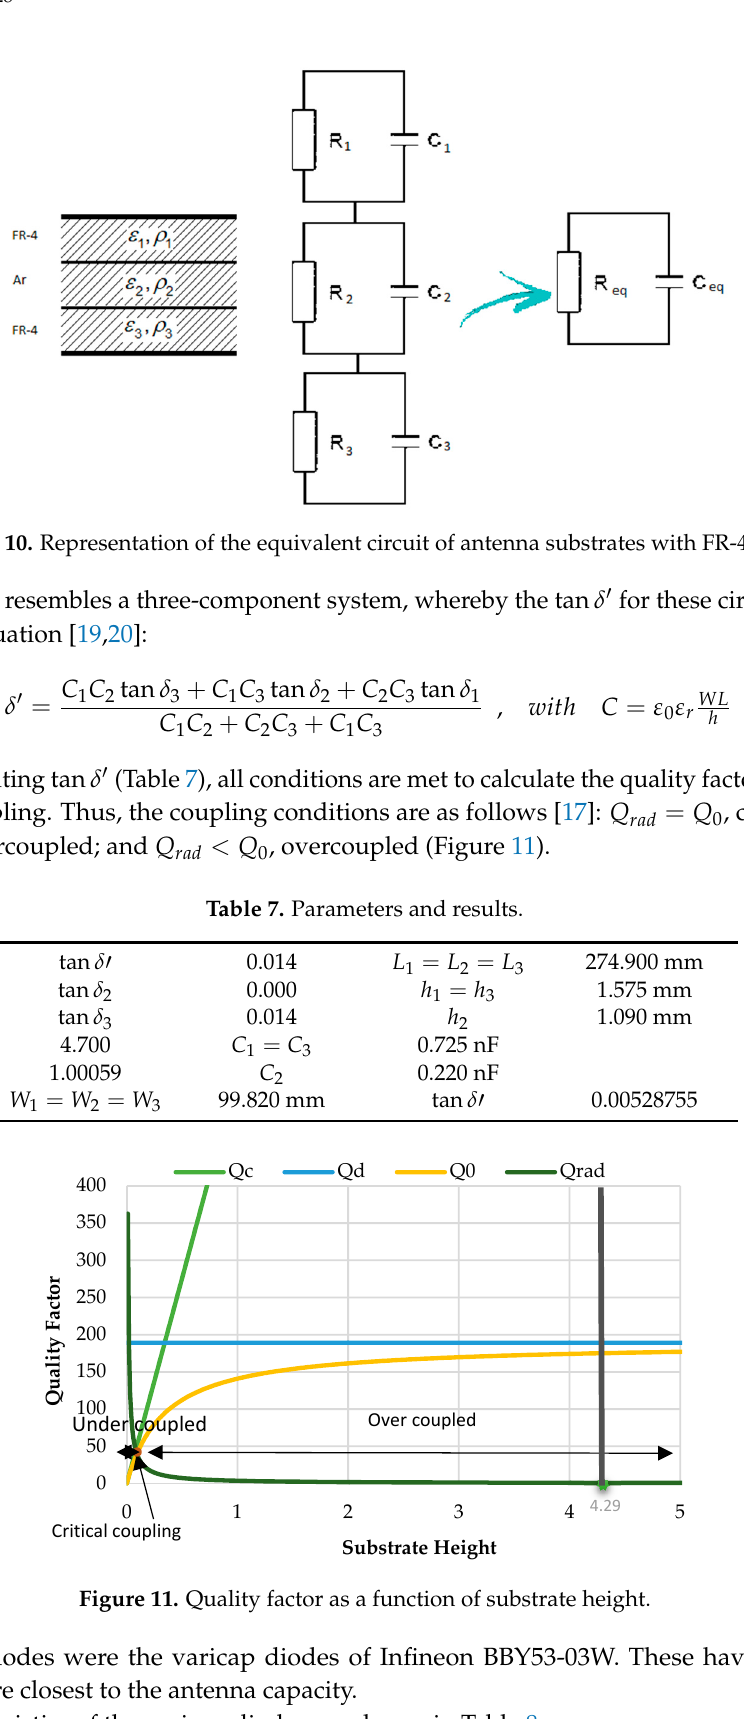
Table 8. Characteristics of varicap diodes.